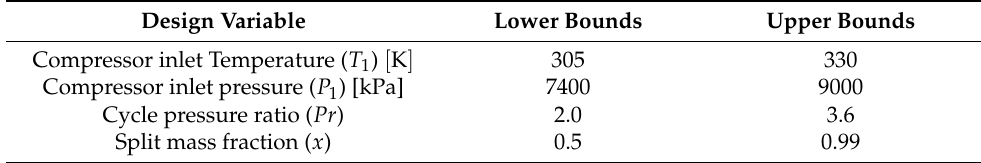
Table 3. Design variables utilized for the present